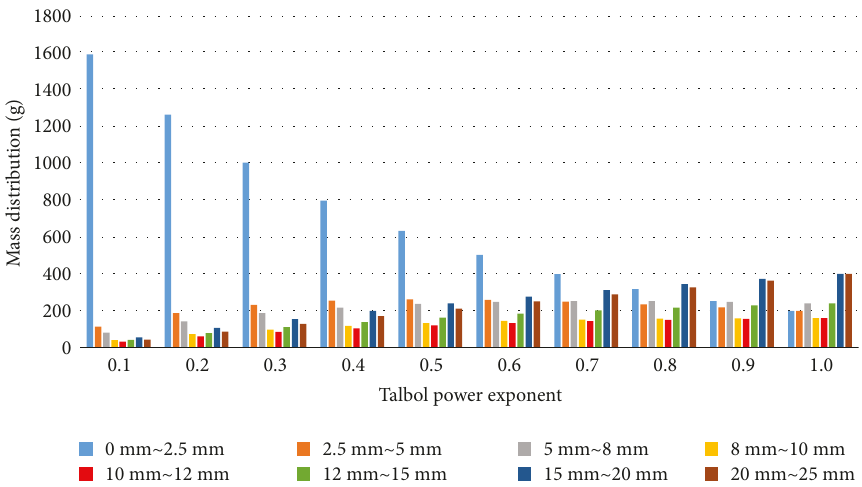
Figure 3: Mass distributions of test samples with various particle sizes in 10 gradations.